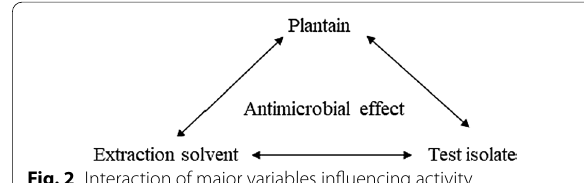
Fig. 2 Interaction of major variables influencing